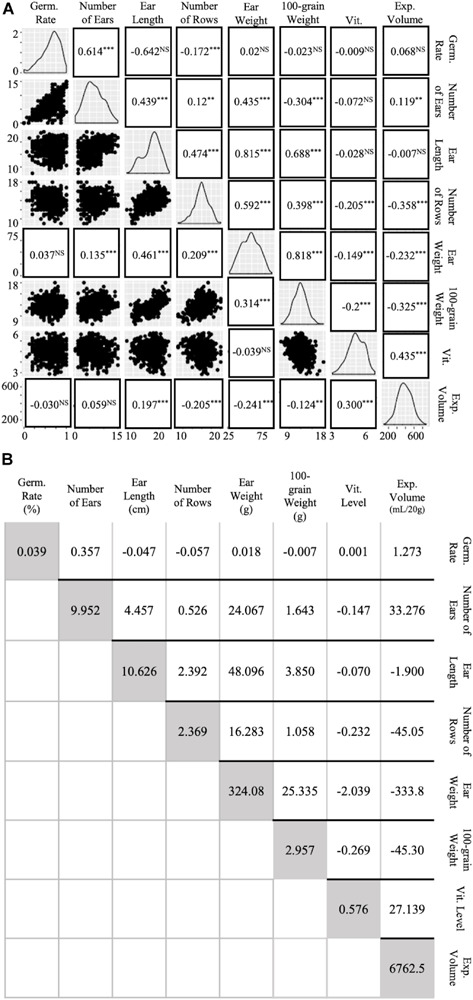
Correlations and covariances of agronomic and popping traits. High covariances and correlations were observed between multiple agronomic traits. (A) Agronomic and Popping Trait Correlations. Diagonal line graphs show normality of trait data. Traits correlate according to x- and y- axis labels. Dot plots under the diagonal show simple regression of traits in x-, y- columns and rows. Standardized values in replacement of dot plots under diagonal were obtained by using a path analysis. Values above the diagonal are Pearson’s Correlation Coefficients of gridded, corresponding traits. Levels of significance: p < 0.0001 “∗∗∗,” p < 0.001 “∗∗,” p < 0.05 “NS.” (B) Agronomic and Popping Trait Variances and Covariances. Covariances of traits according to row and column labeling in gridded fashion are shown above the shaded diagonal. Trait variance is described in shaded diagonal are in trait units shown on horizontal labels.